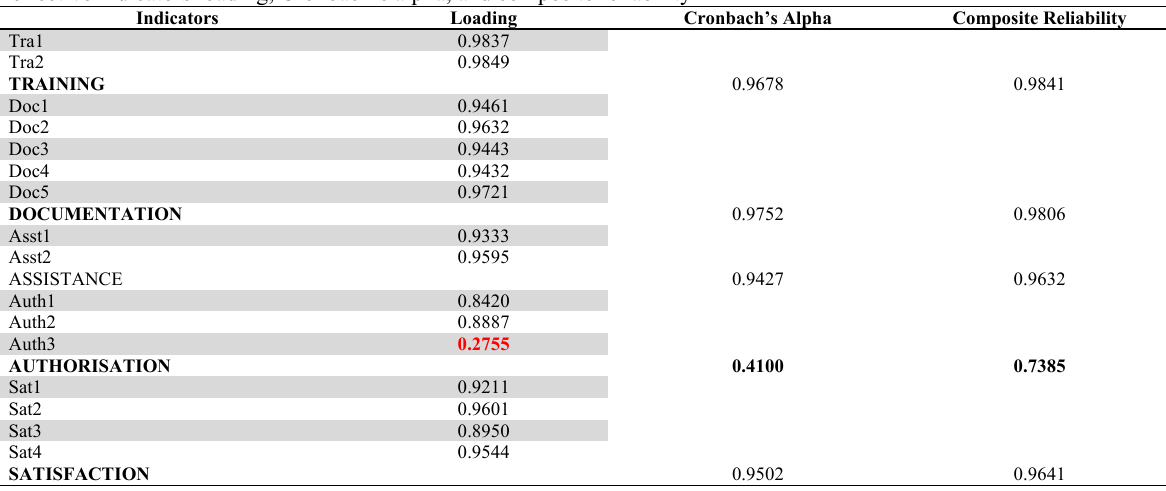
Reflective indicators loading, Cronbach’s alpha, and composite reliability